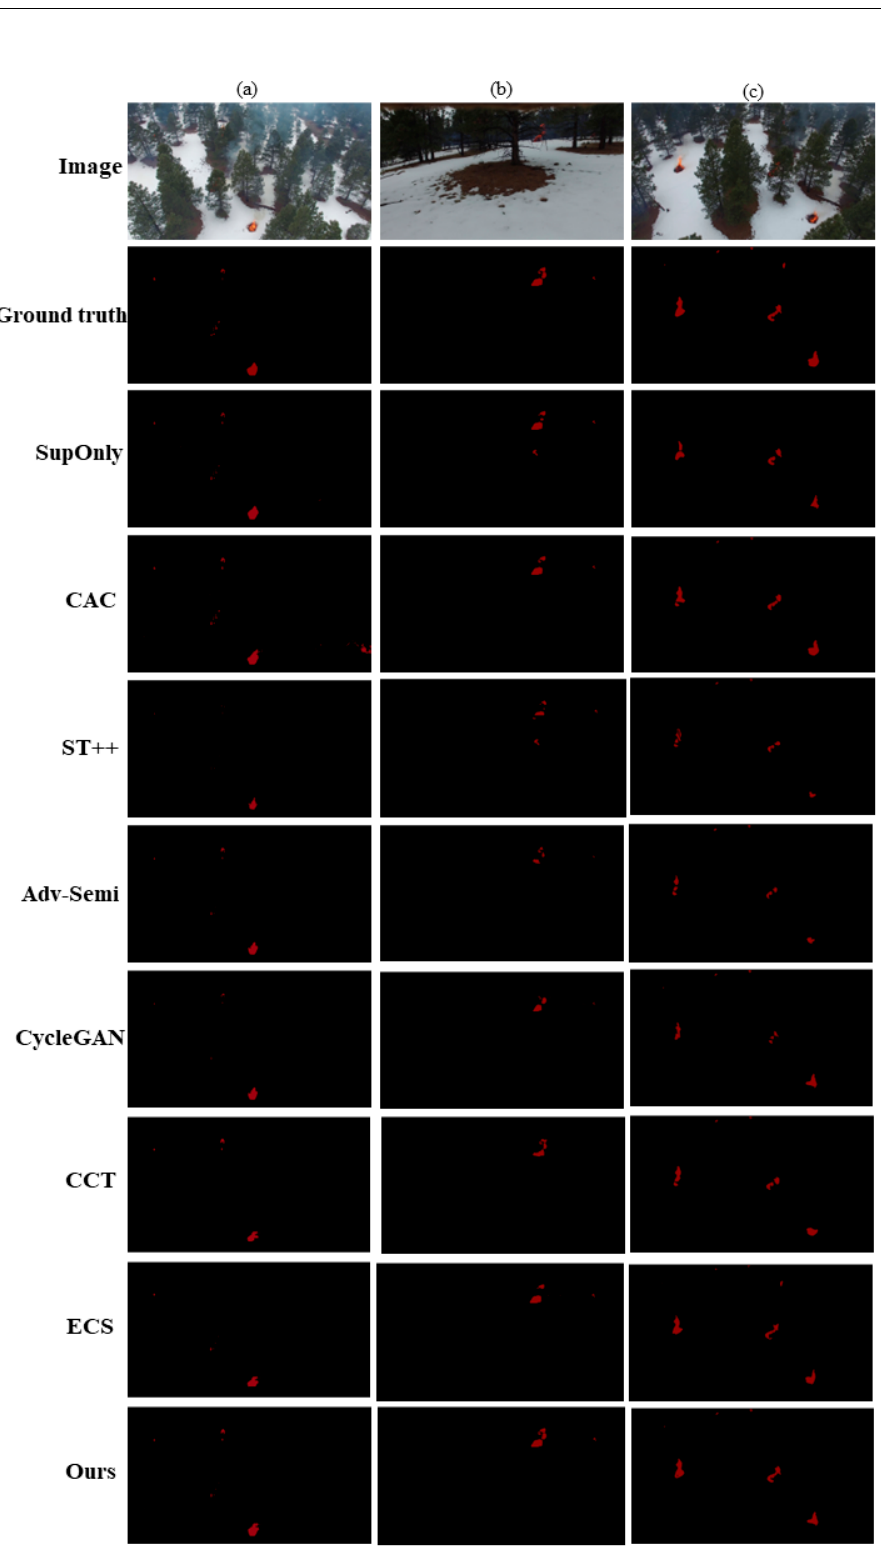
Figure 9. Visualization of segmentation results using the proposed method and state-of-art methods on the Flame dataset, where subfigure ( a ) shows the image of a single fire point taken by UAV from high altitude, subfigure ( b ) shows the image of fire point taken by UAV from low altitude, and subfigure ( c ) shows the image of multiple fire points taken by UAV.